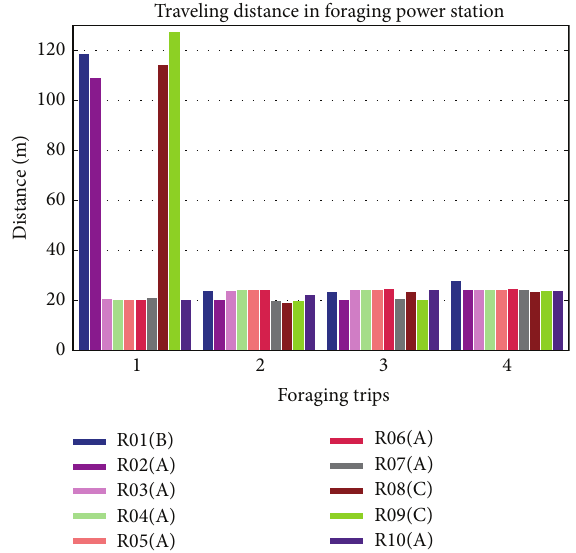
Figure 13: Traveling distance of 10 mobile robots on foraging behavior to power stations A, B, and